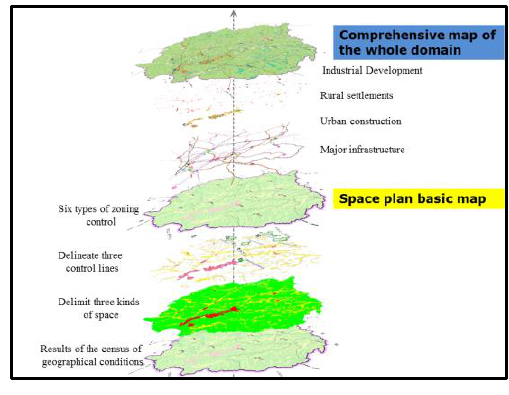
Figure 2.Space plan basic map